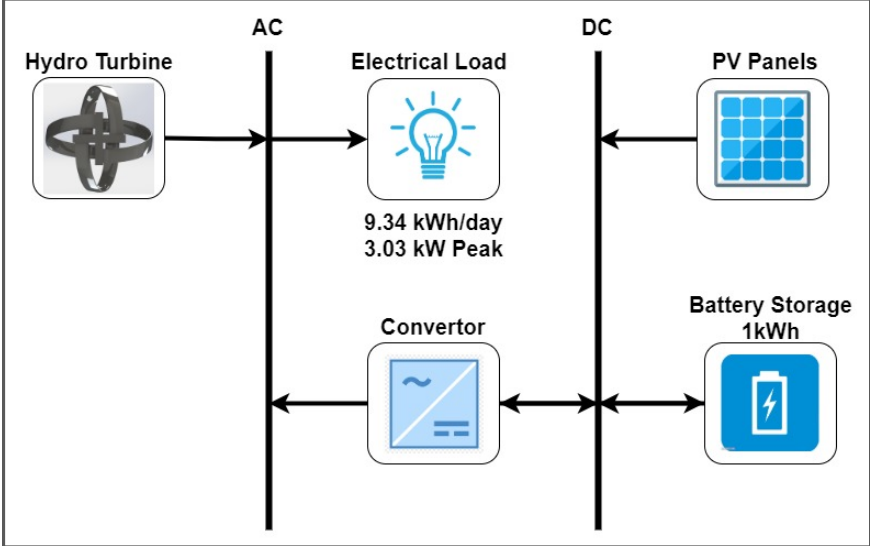
Figure 5. Microgrid configuration designed in HOMER.